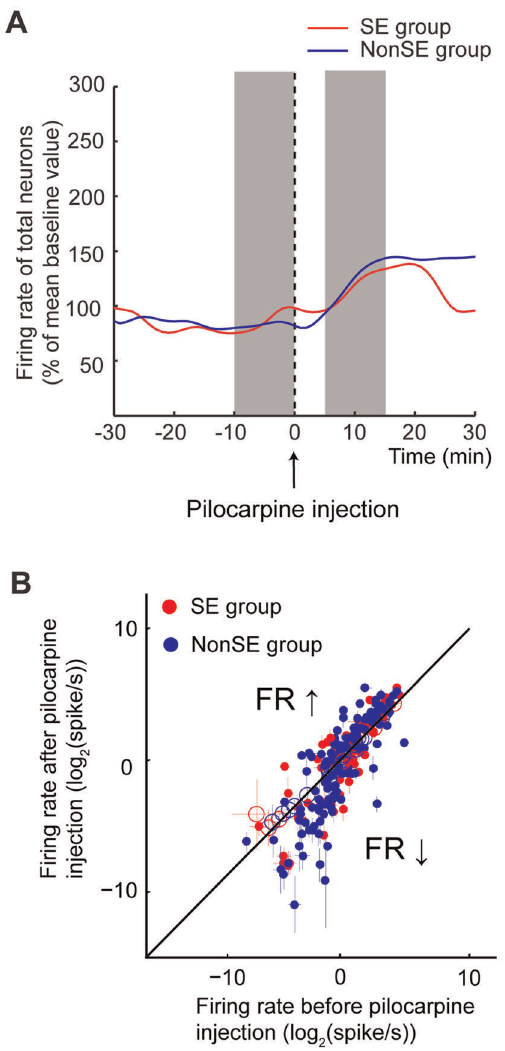
Figure 4. Changes in the firing rates of hippocampal units in pilocarpine-treated rats. A . Relative discharge rates 30 min before and after pilocarpine treatment in SE (red) and nonSE (blue) rats. B . Rate-by-rate comparison of firing rate change before [-10:0 minute] and after [5:15 minute] pilocarpine injection (see gray zones in panel A) of individual neurons from SE (red dots) and nonSE (blue dots) rats. Filled circles indicate significant difference of firing rate after pilocarpine injection. Open circles indicate no change in firing rate.